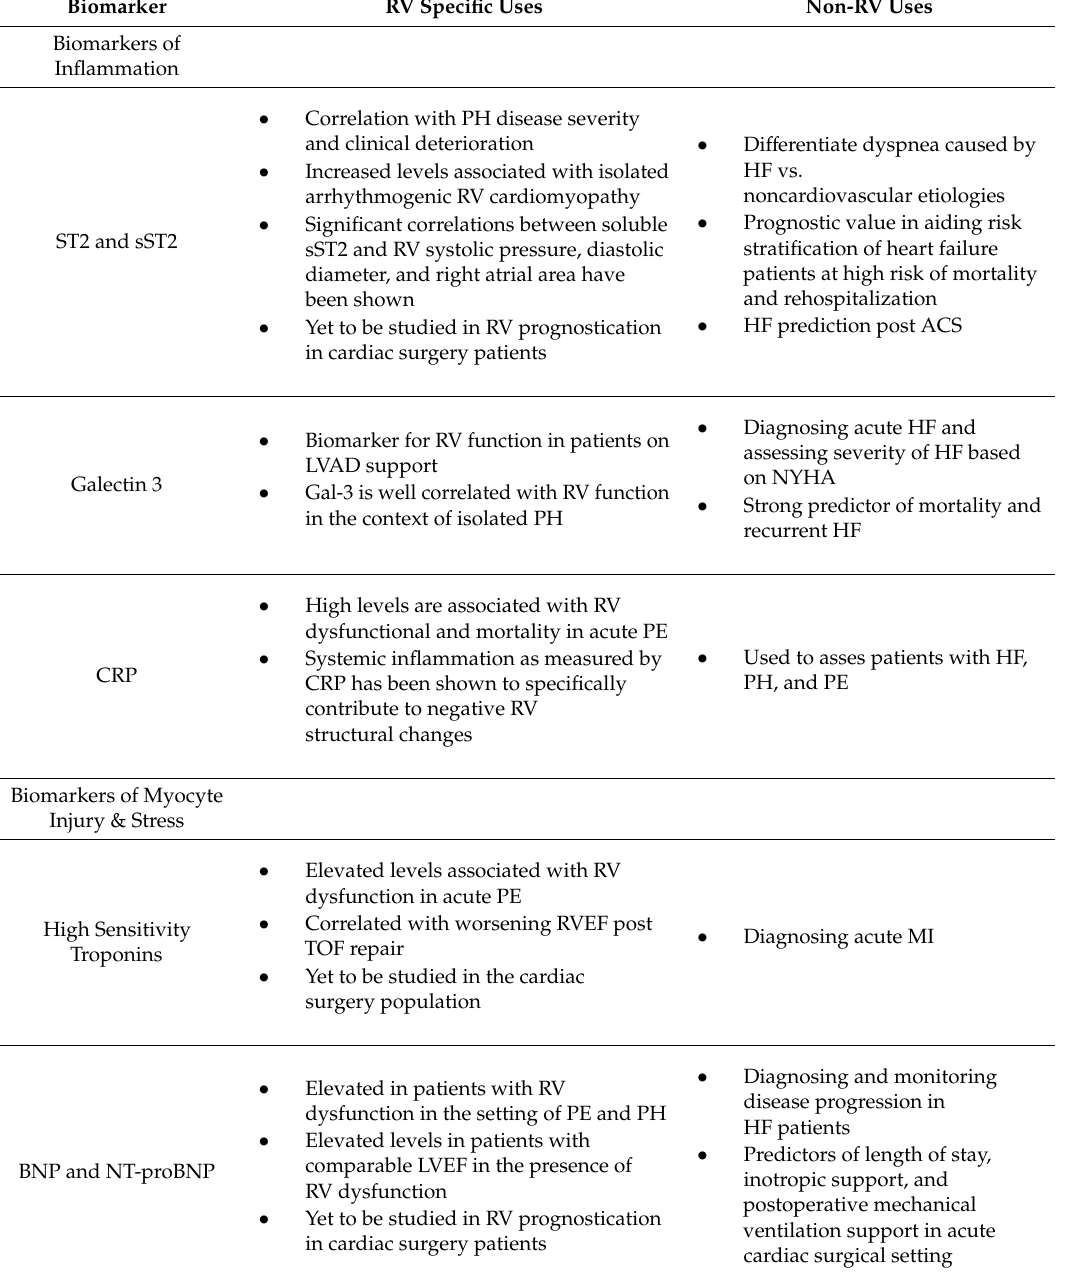
Table 4. RV specific